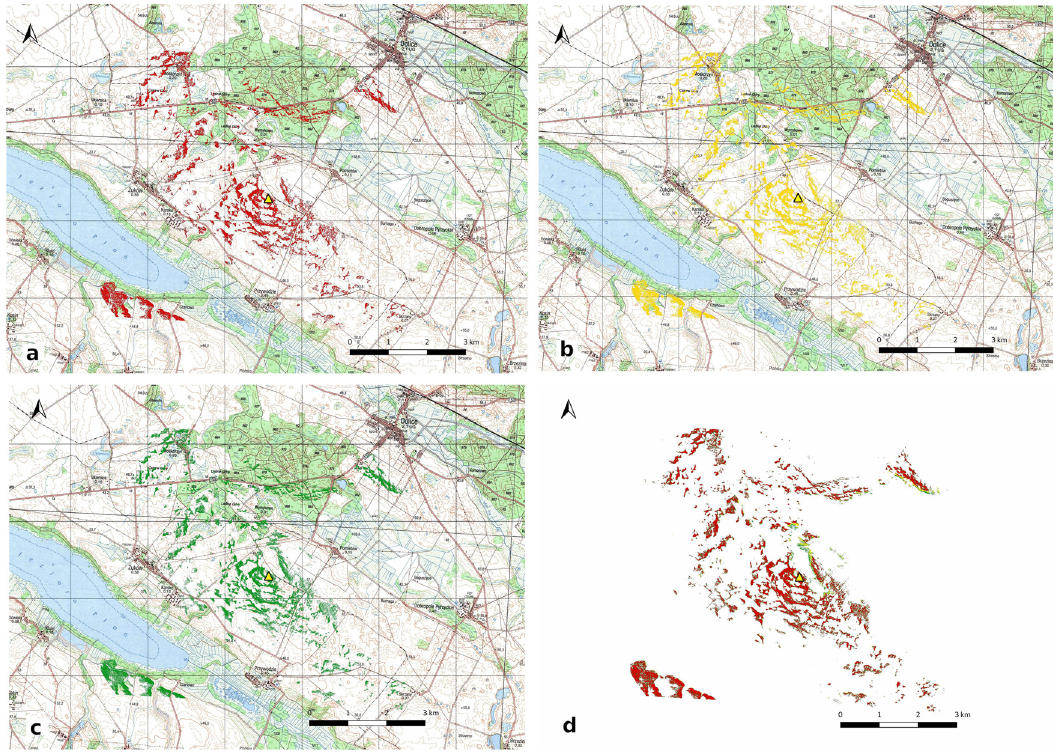
Figure 2: Megalithic tomb at Karsko. Views from the vantage point of a 1.3 m ( a ) , a 1.6 m ( b ) and a 1.8 m ( c ) tall observer standing at the tomb, and the juxtaposed views ( d ) ( M. Schiller )